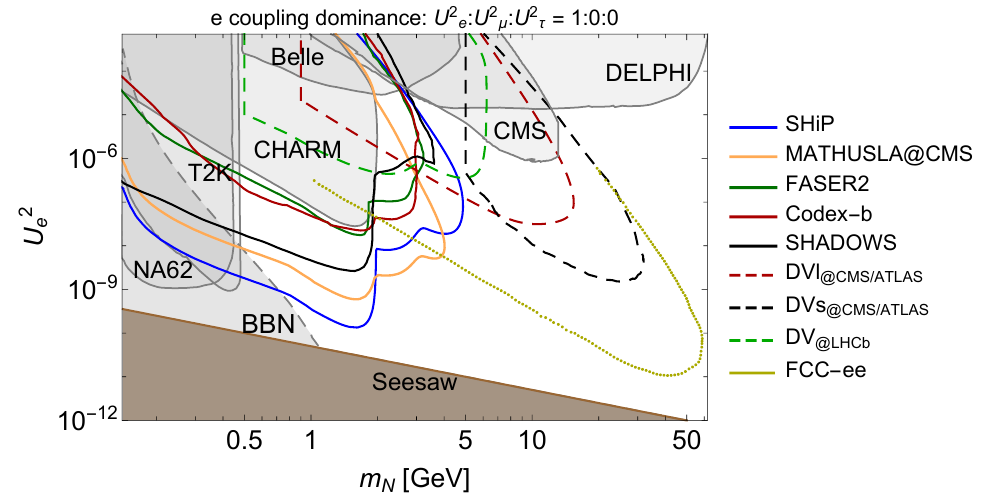
Figure 1 . Constraints on heavy neutral leptons which interact solely with ν e . The domain of currently unexplored parameters lies between the regions excluded by past experiments (see [2, 14] for references), big bang nucleosynthesis [19, 20], and the region in which couplings of HNLs are too small to generate SM neutrino masses (defined by the seesaw bound). The brown domain indicates the couplings for which HNLs are not able to explain the neutrino oscillations data. The colored curves denote the sensitivity of future proposed experiments, including LHC, LHC-based and extracted beam lines experiments (see references in text), and FCC-ee